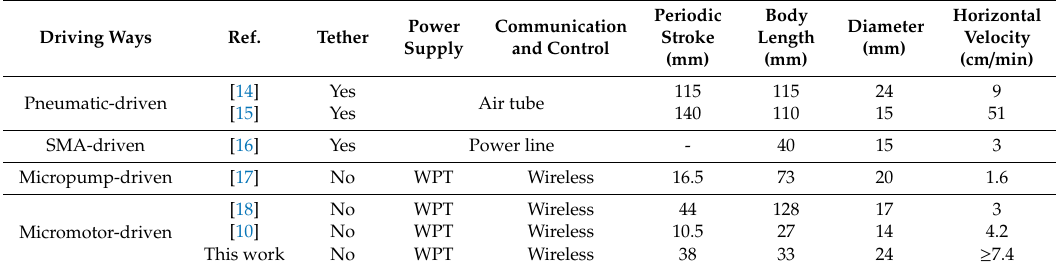
Table 1. Main features of inchworm-like capsule robots